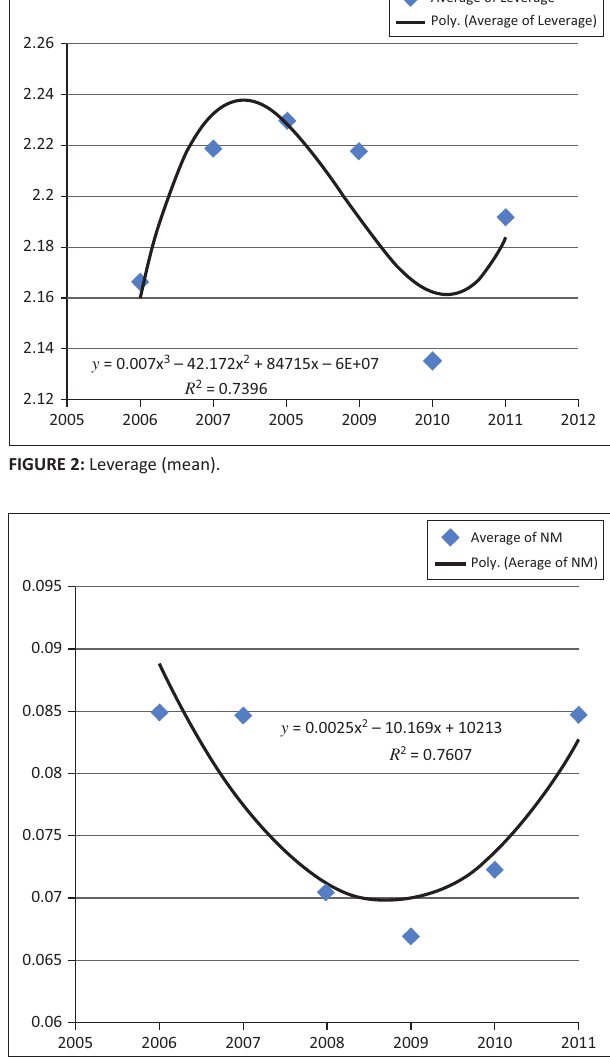
NM, net margin. FIGURE 3: Net margin (mean).